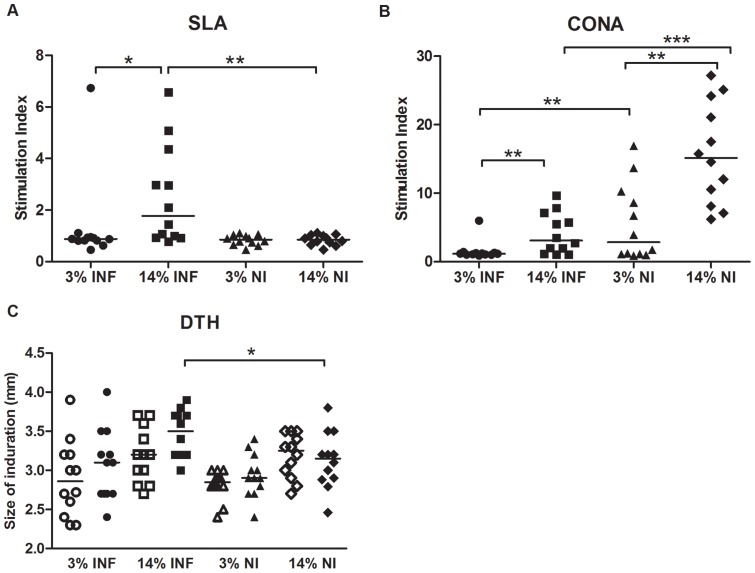
Evaluation of the cellular response and leishmanin test.Lymphoproliferative response to specific SLA (A) and non-specific CONA (B) stimuli, at 113 days post-infection, of PBMCs from infected and non-infected hamsters following the 14% and 3% protein diets. (C) Measurements of the footpads inoculated with PBS (open symbols) and leishmanin (close symbols), taken at 48 h. *p<0.05, **p<0.001. Two independent experiments were performed, one representative experiment is shown.